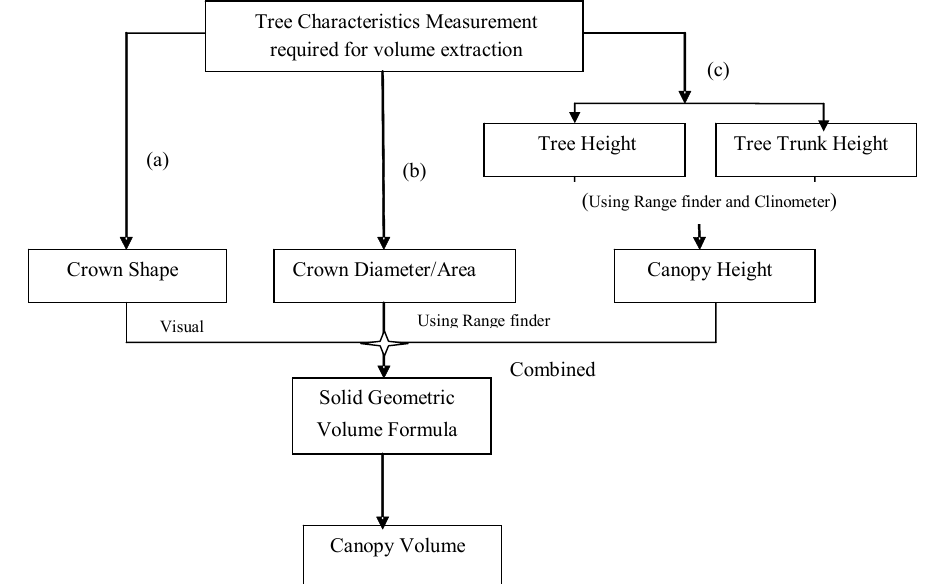
Figure 1. Flow diagram for canopy volume estimations.